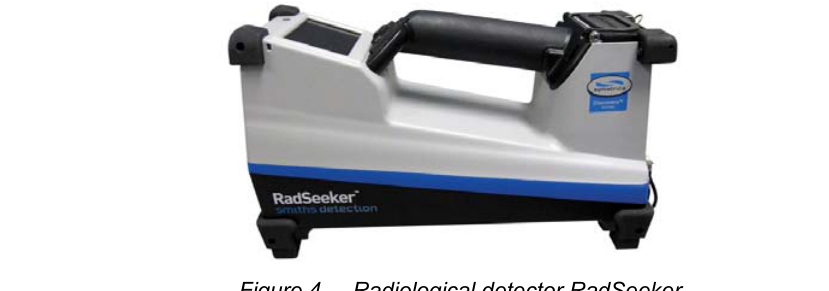
Figure 4 – Radiological detector RadSeeker Рис . 4 – Радиологической детектор RadSeeker Слика 4 – Радиолошки детектор